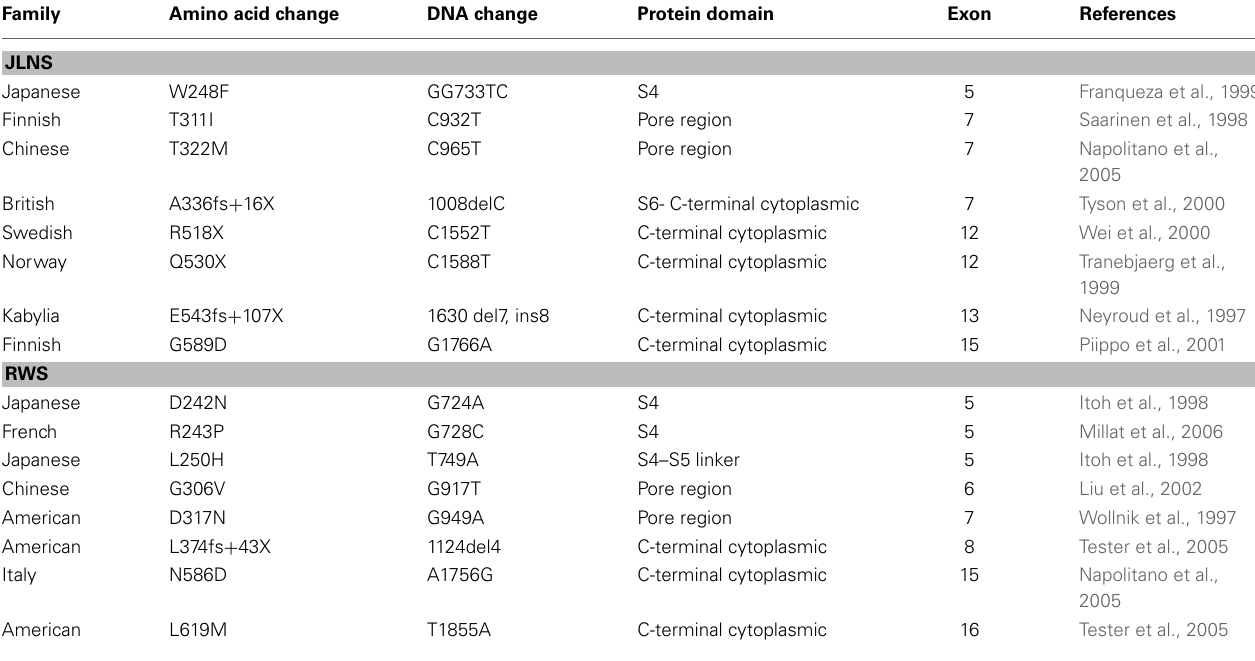
Table 1 | hKv7.1 mutations in JLNS and